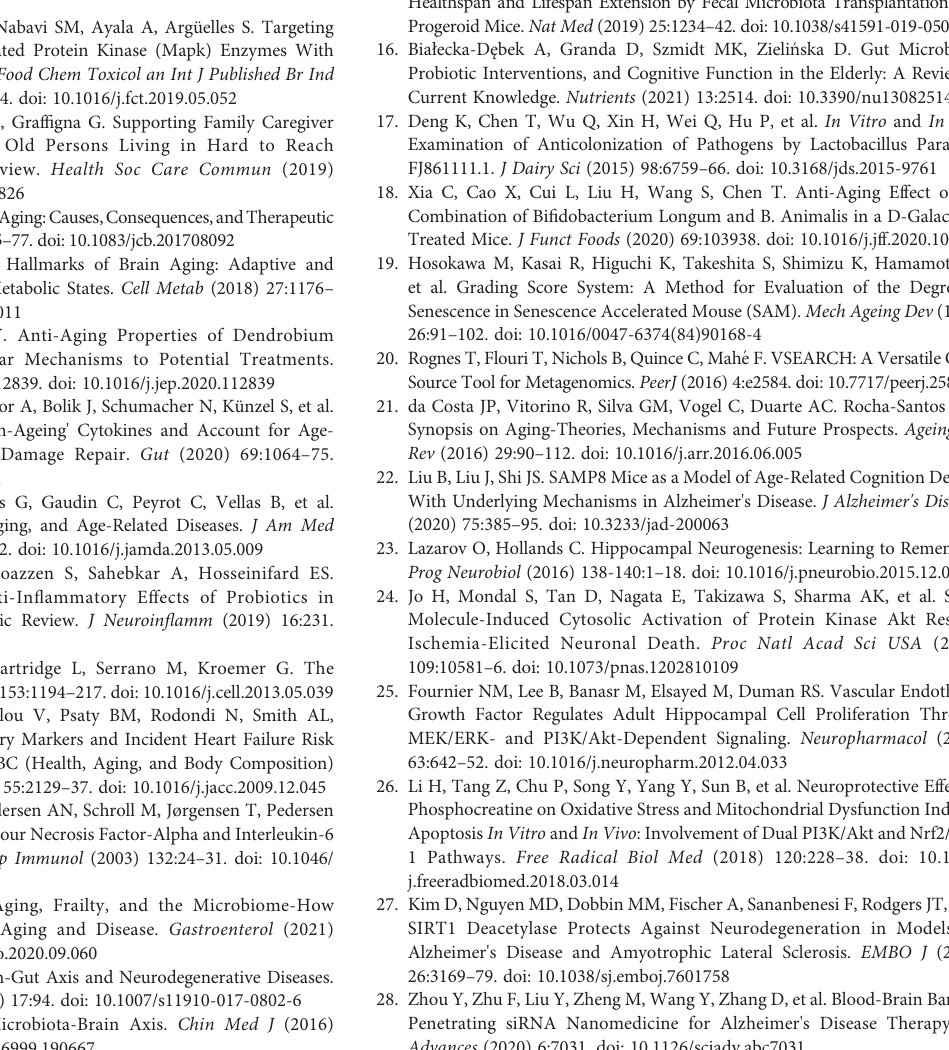
Supplementary Figure 1 | The probiotic combination delayed the decrease in body weight and the increase in the aging score of SAMP8 mice. (A) The experimental design of this study. (B) Weekly body weight changes of SAMP8 mice during gavage of the probiotic combination. (C) Theaging degree scores of SAMP8 mice after gavage of the probiotic combination. C: control group (n = 10), M: model group (n = 9), L: how-dose probiotics group (n = 8), H: high-dose probiotics group (n = 9). Data are presented as the means ± SD. *p < 0.05 **p <